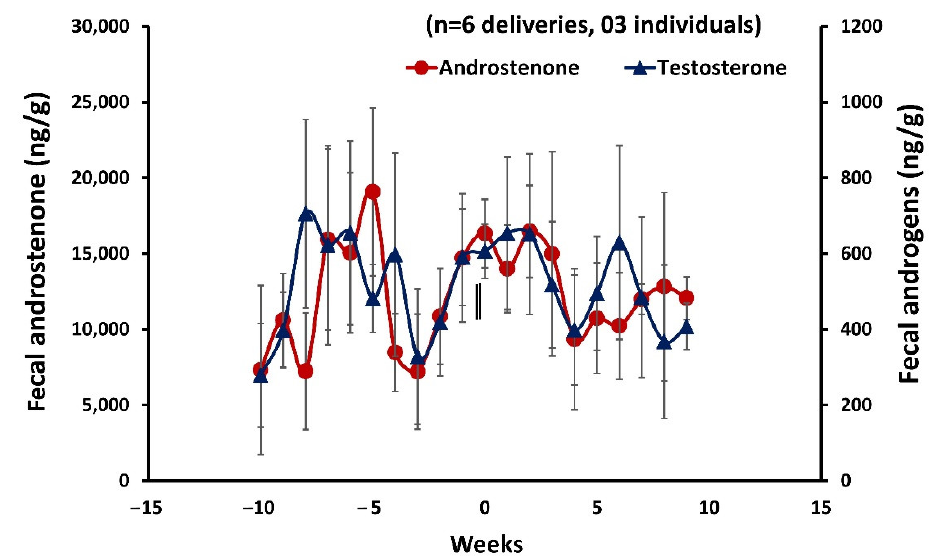
Figure 10. Profile of mean ± SEM weekly fecal androstenone and androgens in male mouse deer during 10 weeks with respect to parturition in females. The zero week and vertical bars indicate the parturition and mating in females.